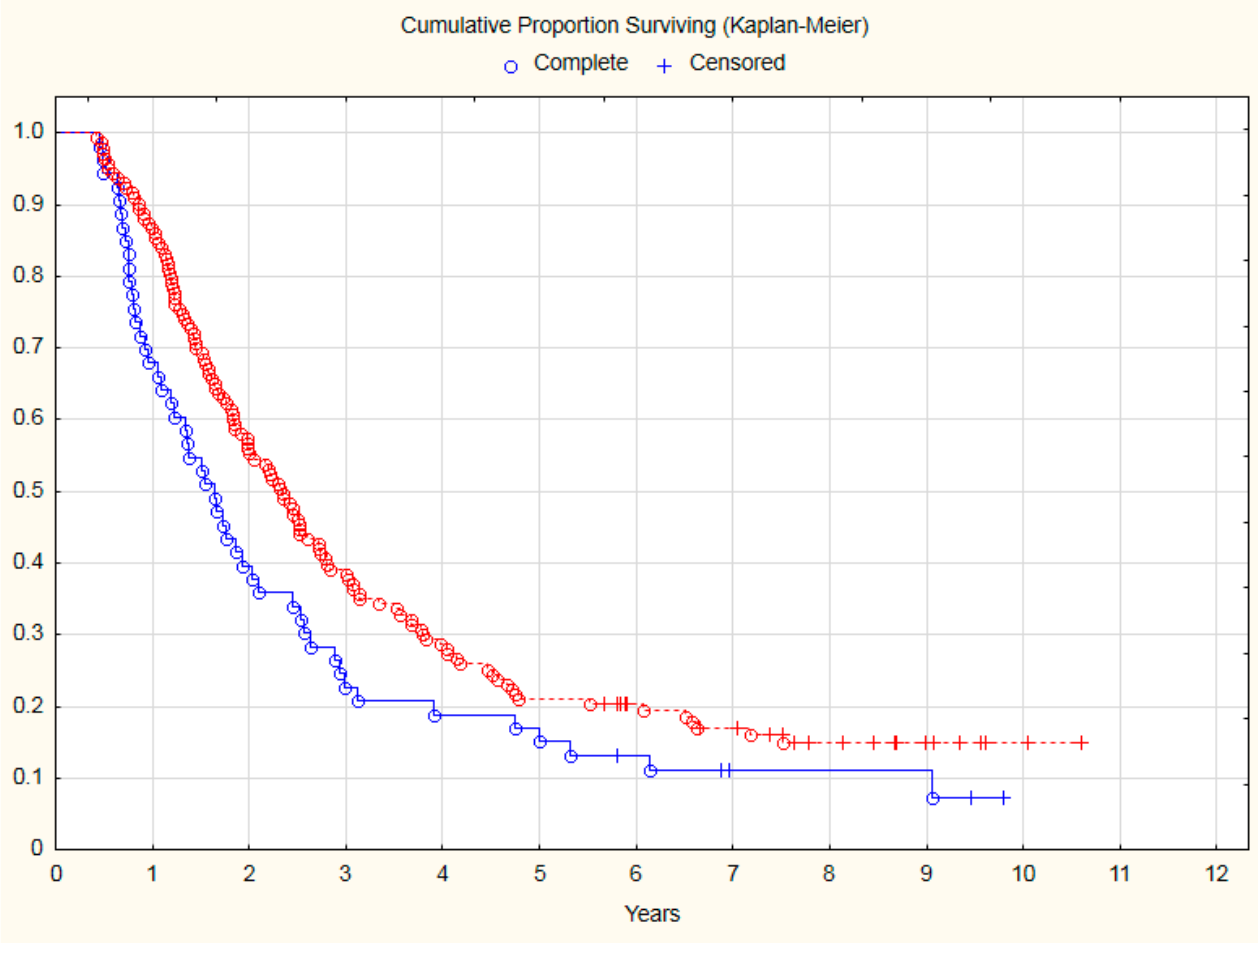
Figure 1. The comparison of OS between NSCLC patients with KPS deterioration during chemoradio- therapy (blue line) and patients with stable performance status (red line). Median of OS: 18.77 months vs. 28.23 months. Risk of mortality: HR = 1.42; 95% CI: 1.02–1.99; p = 0.04.